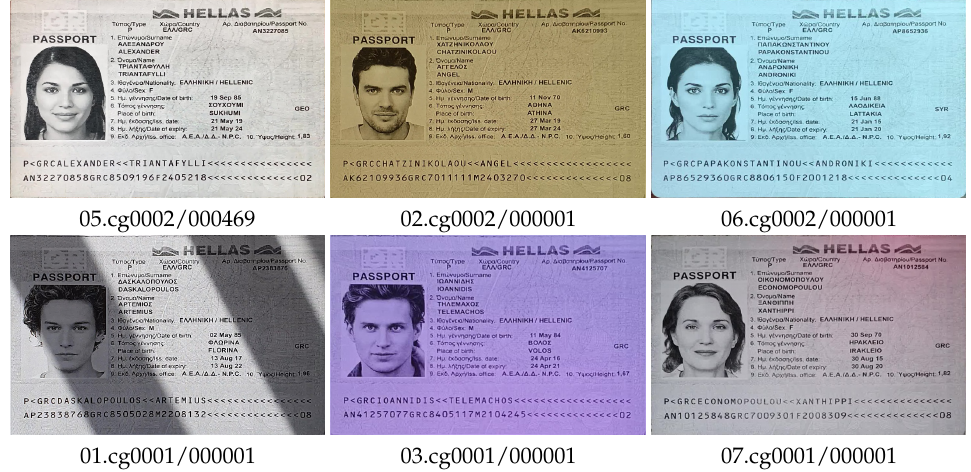
Figure 3. Color variation in gray copies of document images for a variety of capture conditions, type grc_passport.